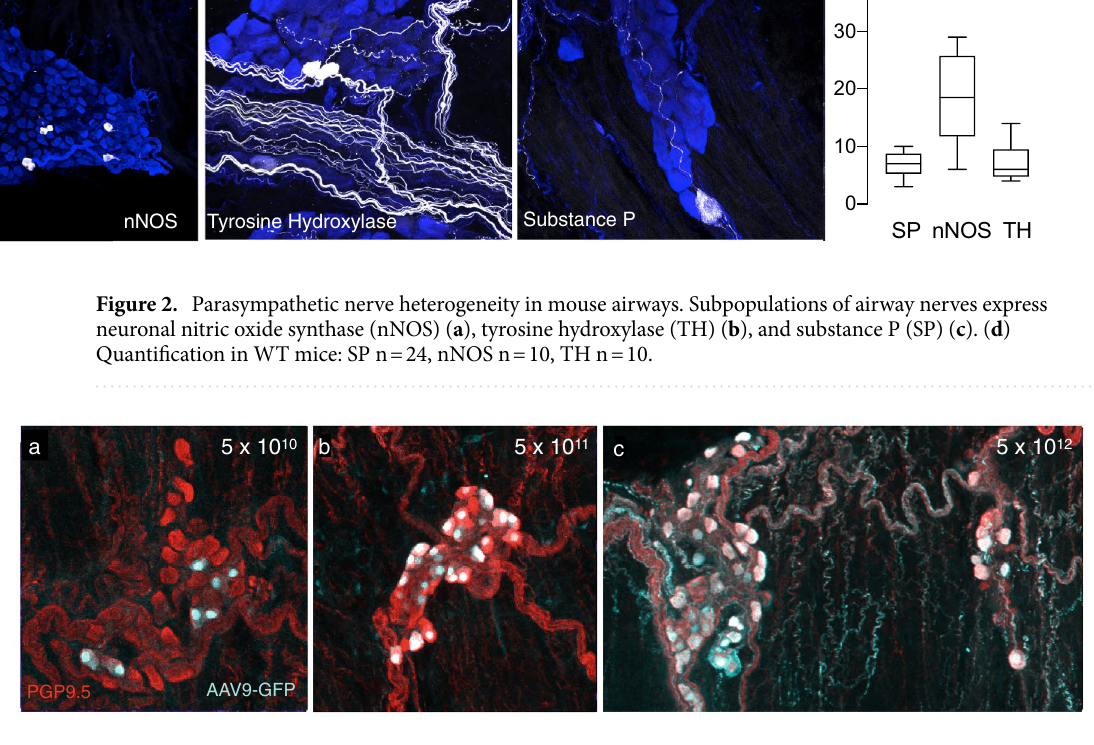
Figure 3. Three viral doses tested for transduction efficiency in airway neurons after intravenous injection. ( a ) Low, ( b ) medium, and ( c ) high doses tested, with successfully transduced neurons expressing GFP and all neurons labeled with PGP9.5. 5 × 10 12 vg showed nearly 100% transduction